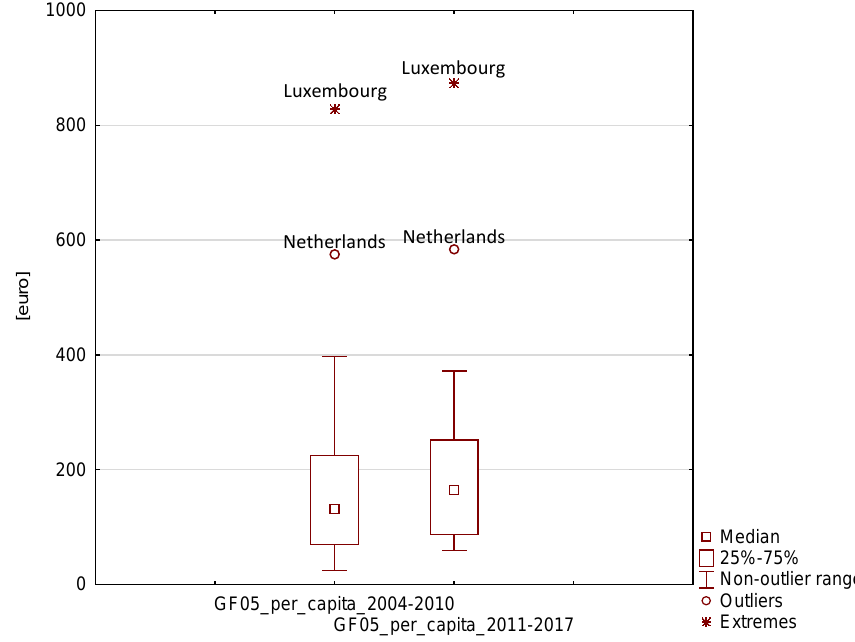
Figure 1. Empirical distribution characteristics of per capita public expenditure on environmental protection in the EU member states in 2004-2010 and 2011-2017. Source: author’s own study carried out using the ‘STATISTICA’